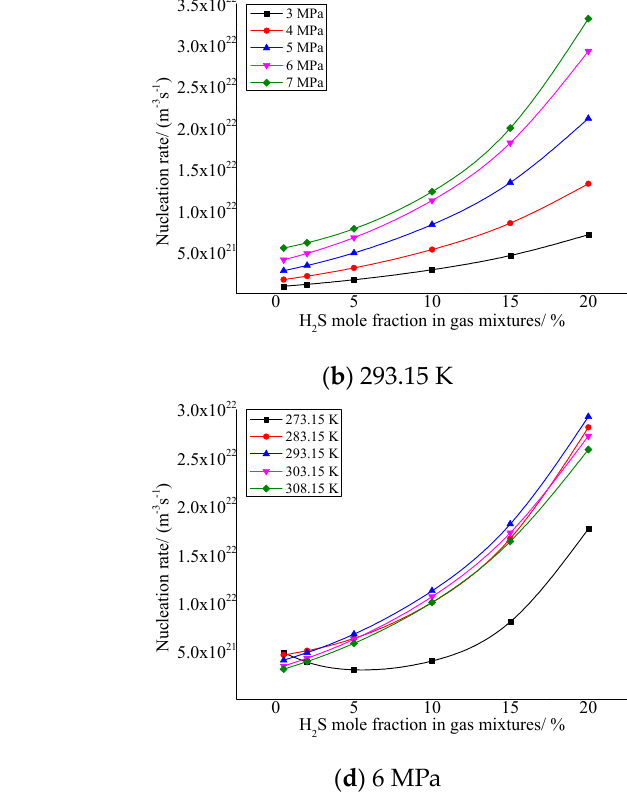
Figure 6. Curve of nucleation rate with concentration of H 2 S.